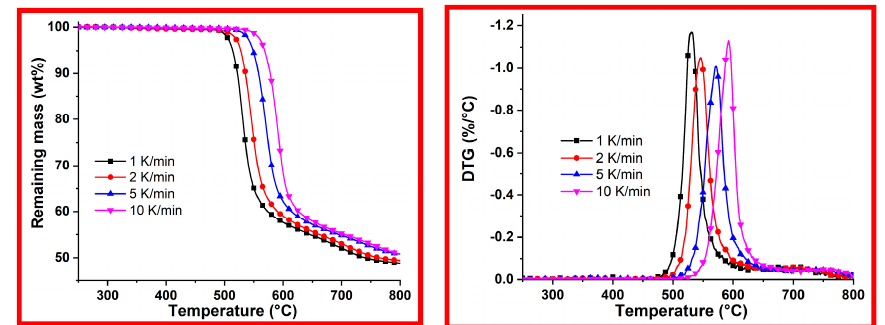
Figure 3. TG (left) and the corresponding DTG (right) curve of PEEK at 1 (black), 2 (red), 5 (blue), and 10 K/min (magenta), under nitrogen.